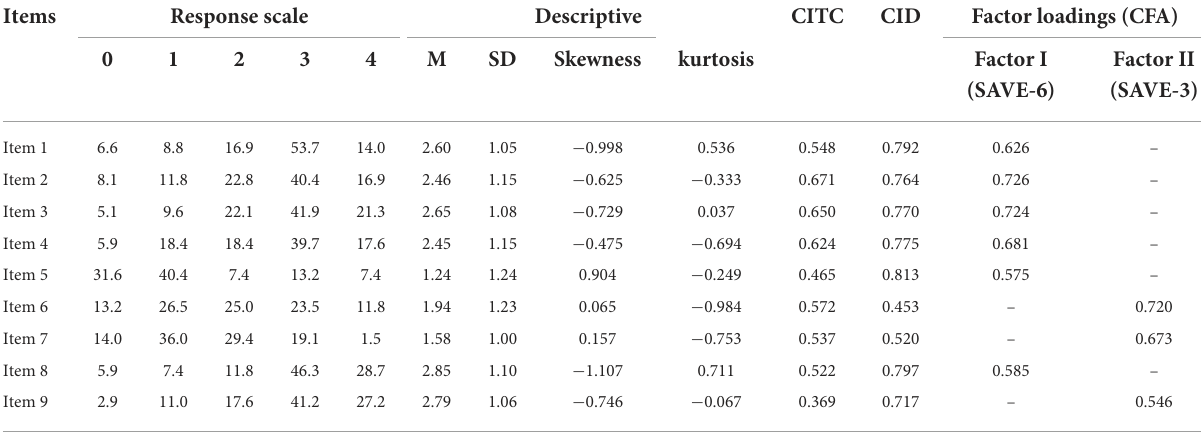
TABLE 2 Item properties of the SAVE-9 scale among nursing professionals working in COVID-19 inpatients wards. Items